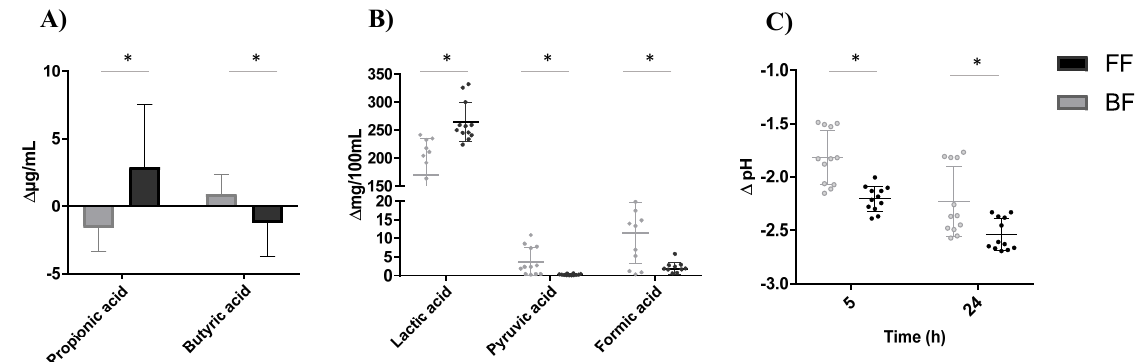
Figure 5. Variations in the levels of propionic and butyric acid ( A ), lactic, pyruvic and formic acid ( B ) and pH ( C ) with respect to values in baseline (time 0) after 24 h of incubation in fecal cultures. *, Significant differences at p < 0.05.